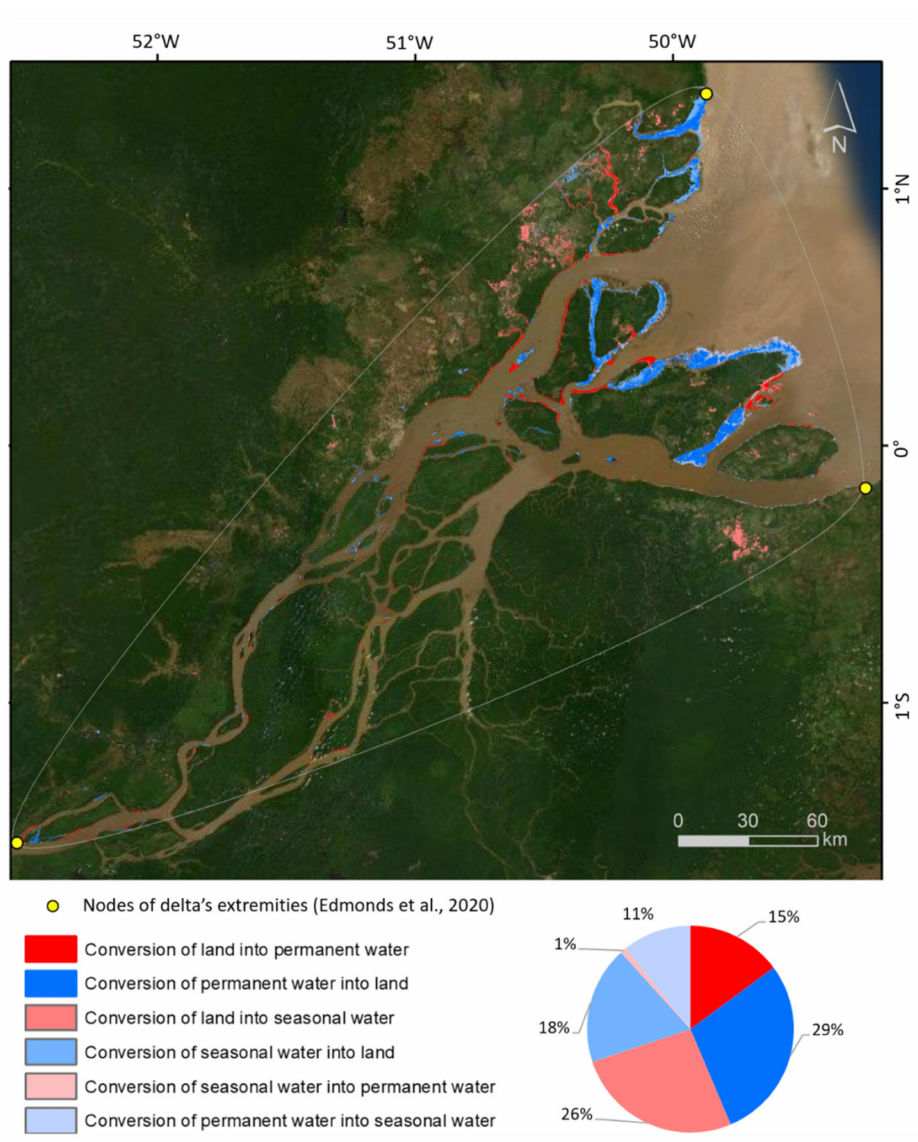
Figure 3. Various categories of land-water and water-land conversion in the Amazon River delta between 1984 and 2015 generated by [51], downloaded from the European Union’s https: //global-surface-water.appspot.com/download (accessed 15 February 2021) and superimposed on a Copernicus Sentinel 2 satellite image dated 15 October